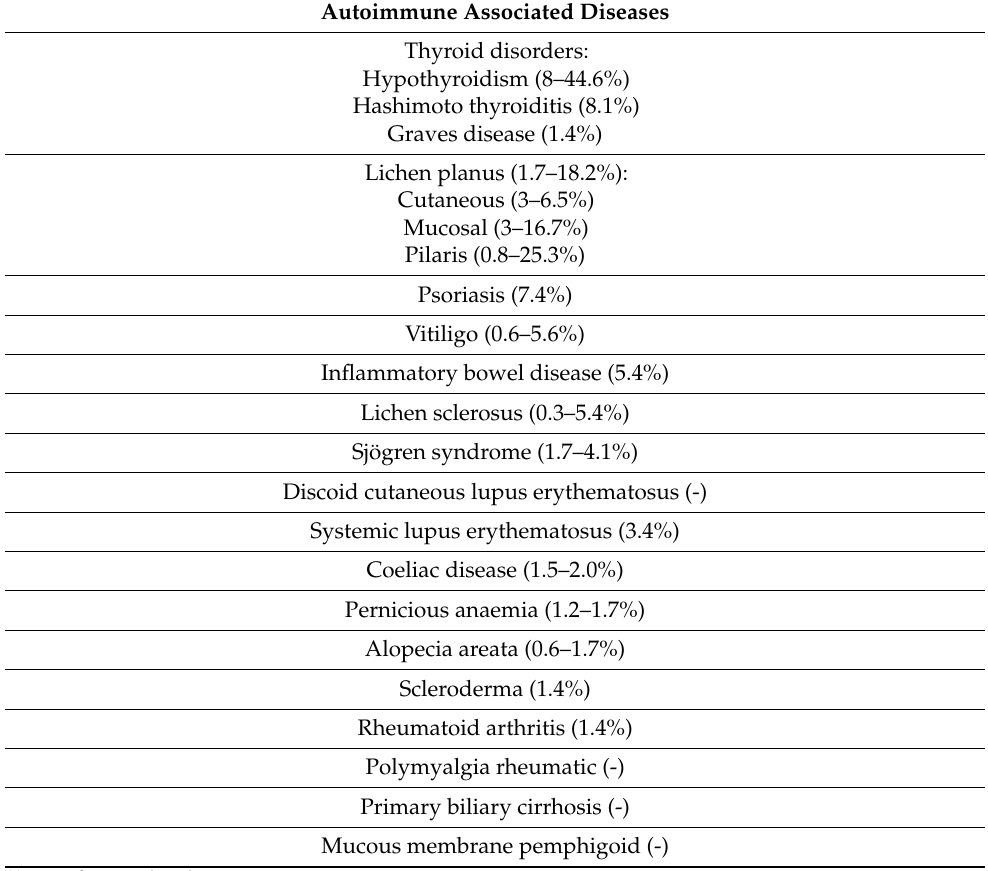
Table 1. Autoimmune diseases described concomitantly with